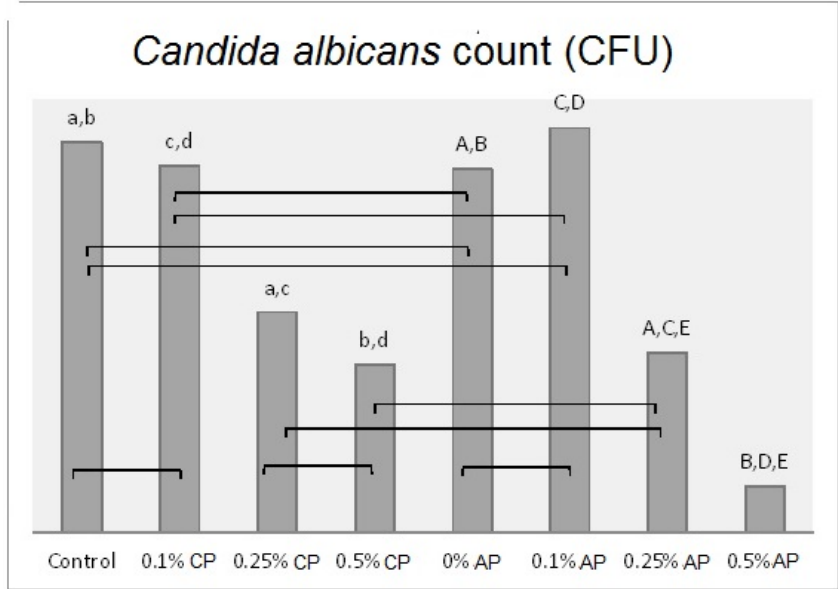
Figure 6. Mean of Candida albicans (CFU/mL) count and significances between groups for ND concentrations and polymerization techniques. Same lower-case letters a, b, c, d show significant differences between the means in CP group. Same upper-case letters A, B, C, D, E show significant differences between the means in AP group. Lines show the insignificant differences comparing polymerization techniques.